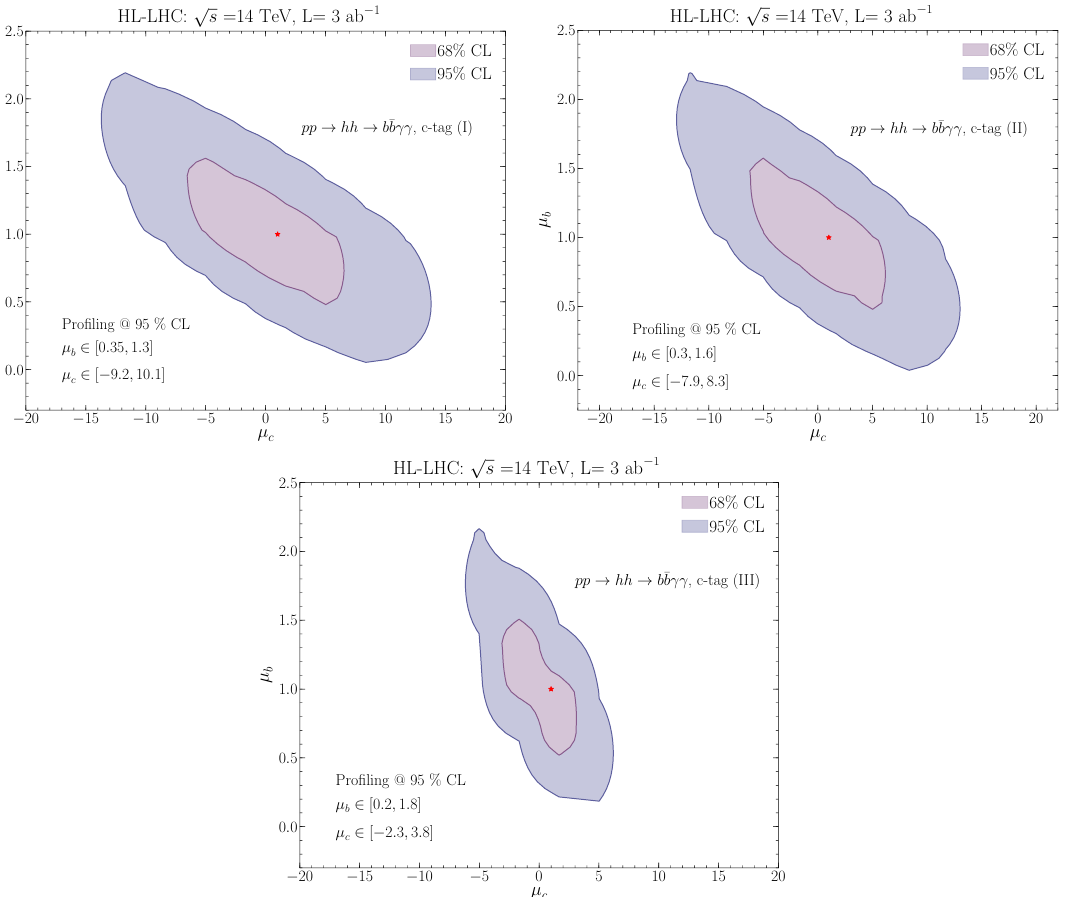
Figure 16 . The expected sensitivity likelihood contours at 68% CL and 95% CL for an integrated luminosity L = 3000 fb (cid:0) 1 for the signal strengths (cid:22) c and (cid:22) b , using the c-tagging I ( upper pannel, left ), II ( upper pannel, right ) and III ( lower pannel ) working points combined with the ATLAS med b -tagging working